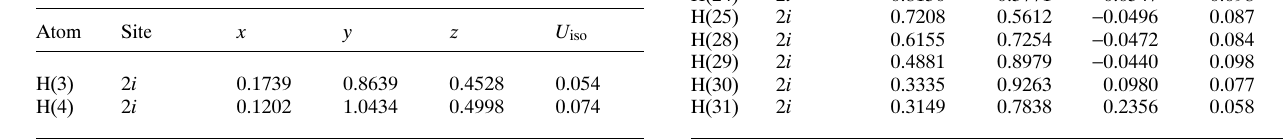
Table 2. Atomic coordinates and displacement parameters (in Å 2 ) .